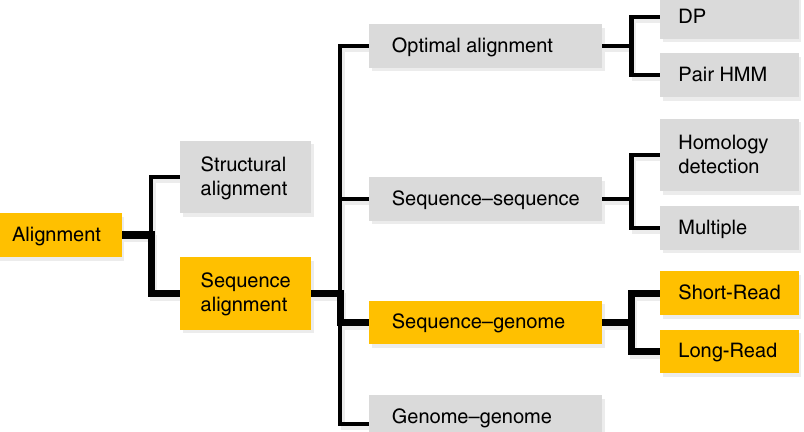
Fig. 1 Classi fi cation of alignment problems. The hierarchy classi fi es various forms of alignment problems. Our proposed approach belongs to the yellow marked subgraph of the